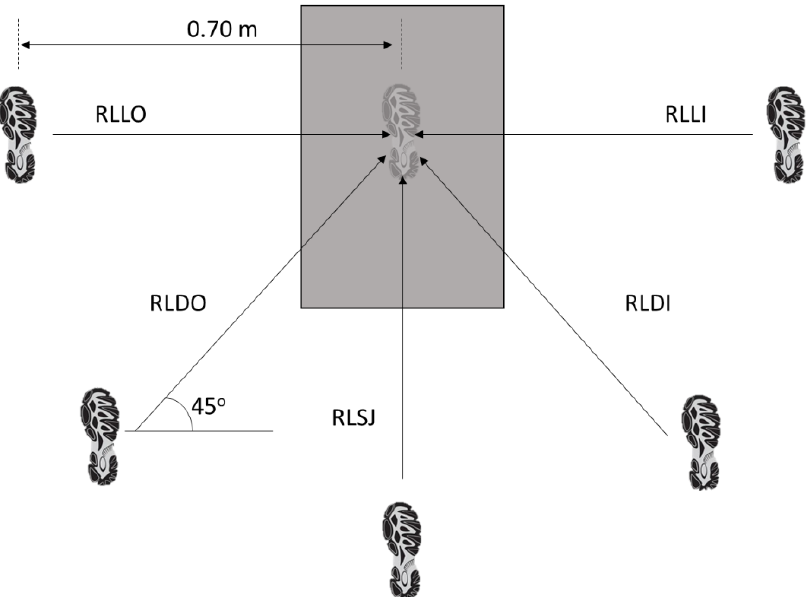
Figure 1. Multidirectional landing setup for the dominant leg (i.e., right leg (RL)). The grey box represents the force plate. RLLI, right leg lateral inside; RLDI, right leg diagonal inside; RLSJ, right leg straight jump; RLDO, right leg diagonal outside; RLLO, right leg lateral outside. All directions were repeated on the non-dominant